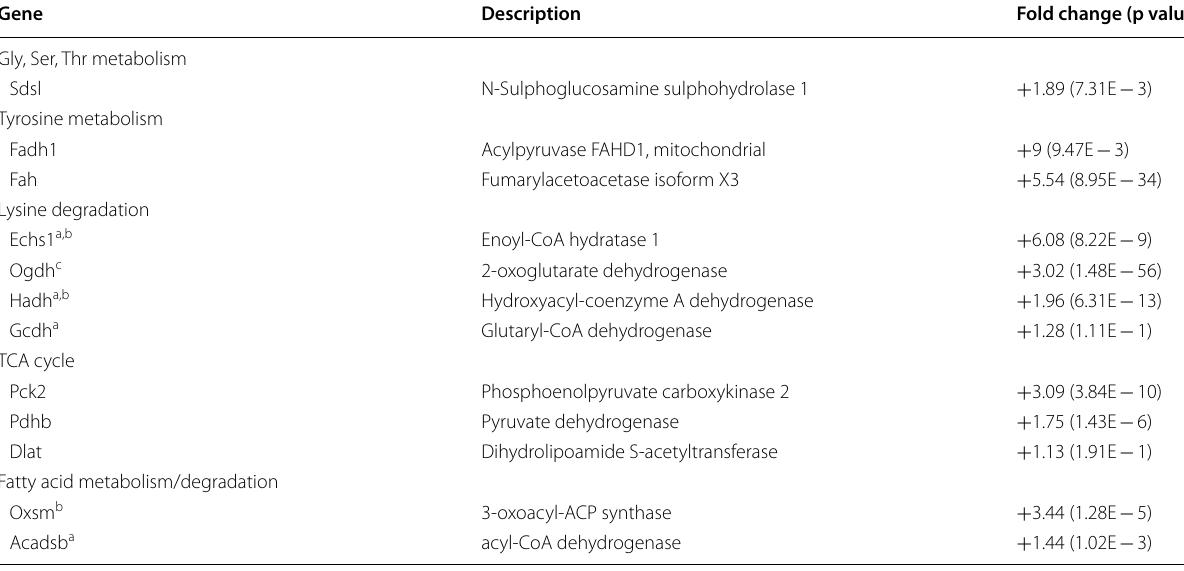
a Genes also involved in fatty acid degradation pathway b Genes also involved in fatty acid metabolism c Genes also involved in TCA cycle. Fold change values included here only represent differentially expressed genes in V205, the highest titer condition